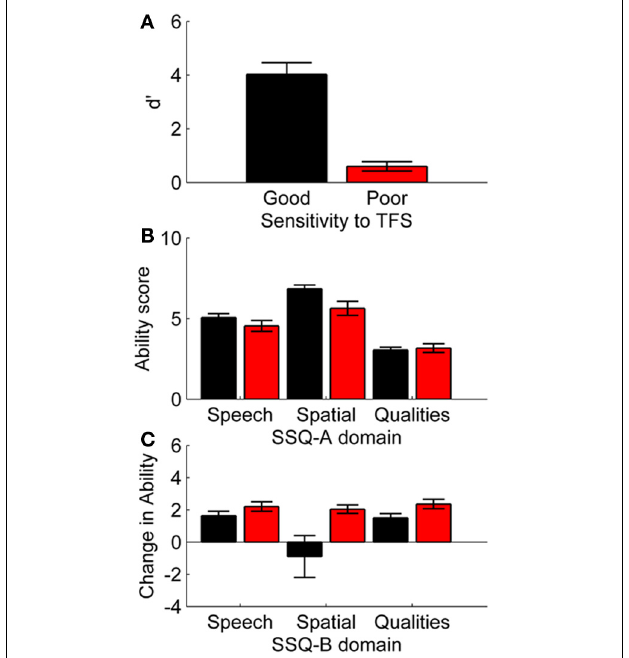
FIGURE 3 | Sensitivity to TFS information and self-reported listening abilities. (A) discriminability index (d (cid:3) ) of participants classified as having good or poor sensitivity on the basis of whether they completed the TFS-LF test adaptively (good sensitivity) or reverted to a method of constant measures (poor sensitivity), (B) SSQ-A self-report scores for participants with good sensitivity to TFS information (black bars) or poor sensitivity to TFS information (red bars), (C) SSQ-B self-report scores for participants with good sensitivity to TFS information (black bars) or poor sensitivity to TFS information (red bars). Error bars show ± 1 standard error of the mean.